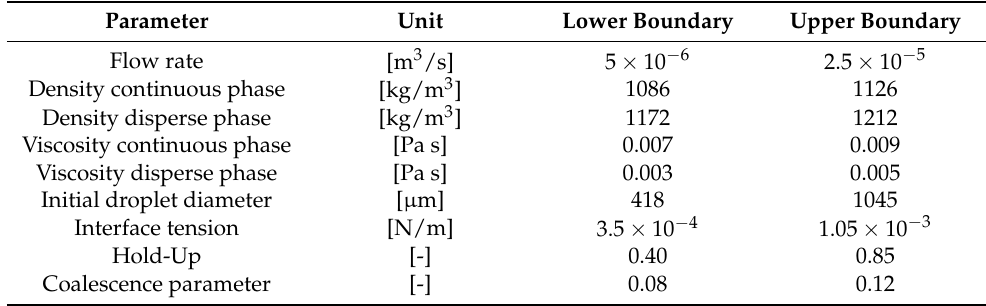
Table 2. Parameters and value range of the MFAT simulation